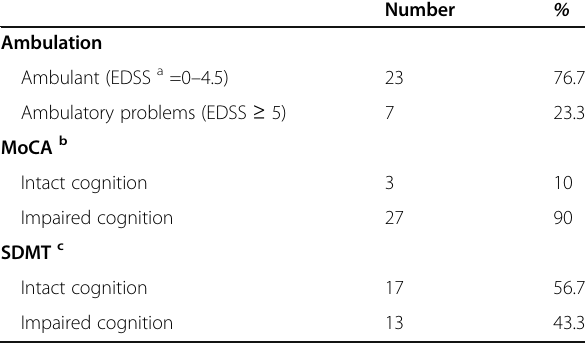
Table 1 Clinical characteristics of the studied